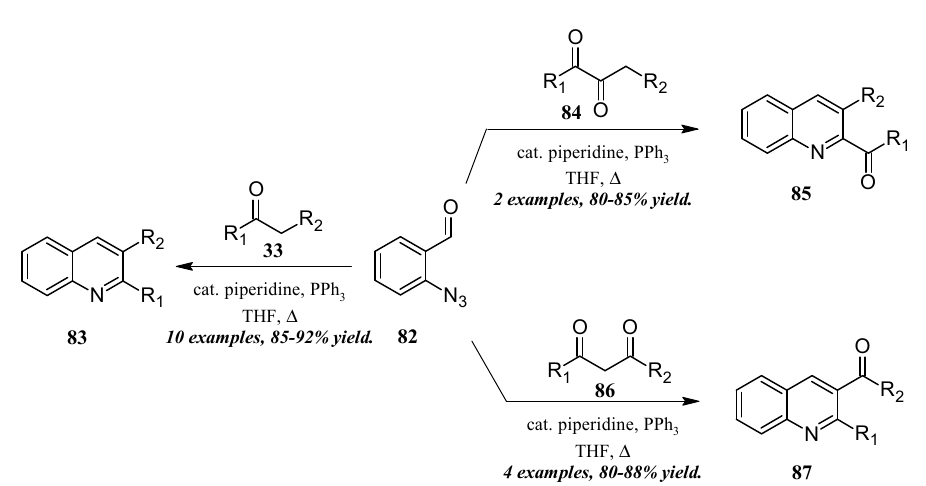
Figure 37. Aza-Wittig cascade reaction of azidobenzaldehyde with mono- and dicarbonyl compounds.